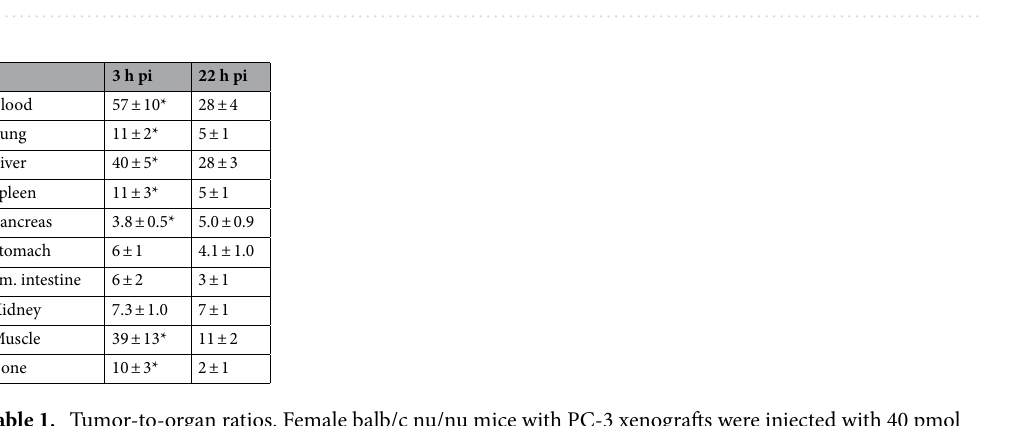
Figure 4. (a) Biodistribution and (b) in vivo specificity of [ 66 Ga]Ga-NOTA-PEG 2 -RM26. Female balb/c nu/nu mice with PC-3 xenografts were injected with 40 pmol (40 kBq) [ 66 Ga]Ga-NOTA-PEG 2 -RM26. For the in vivo specificity test mice in the blocked group were co-injected with 10 nmol non-labeled NOTA-PEG 2 -RM26. Data is presented as %IA/g as average ± standard deviation (n = 3–4 animals/group). Data for GI and body is expressed as %IA. * indicates statistical significant difference (p < 0.05).